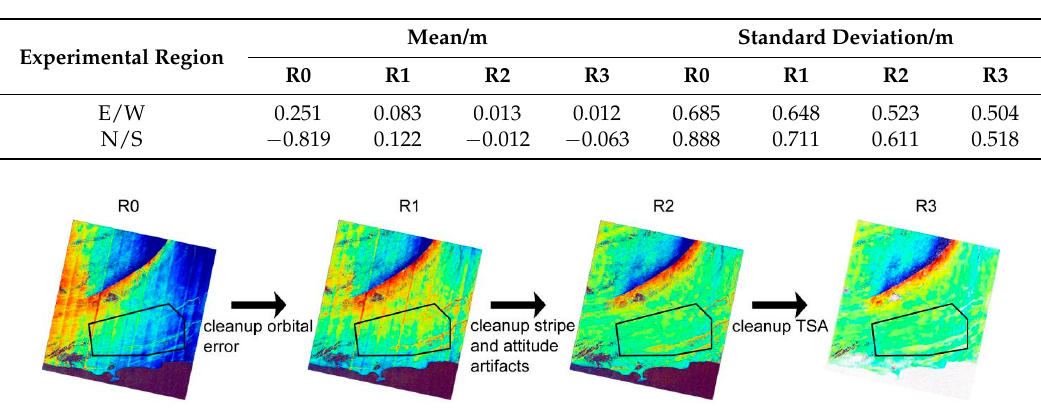
Figure 11. Flow chart of accuracy improvement in the Landsat 8 crustal deformation field. The black polygon line denotes the area used for accuracy assessment.